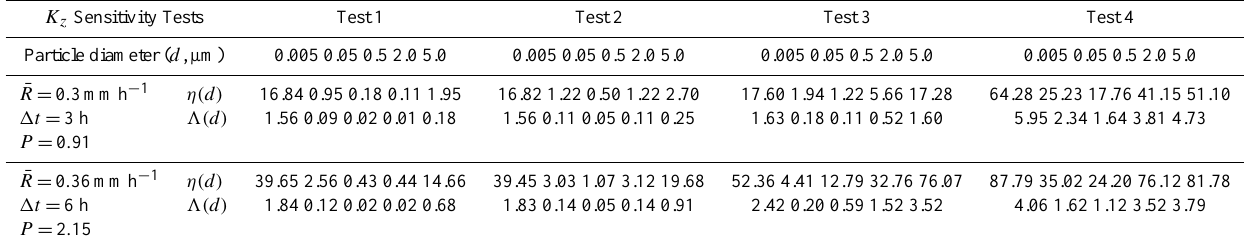
Table 2. Same as Table 1 but after 3 and 6h of weak precipitation